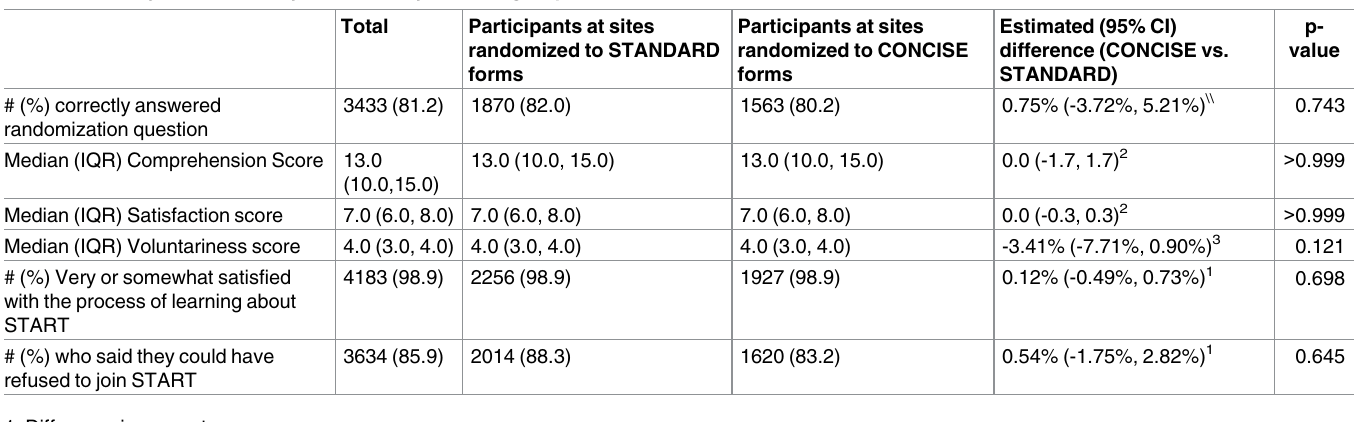
Table 3. Primary and secondary outcomes by consent